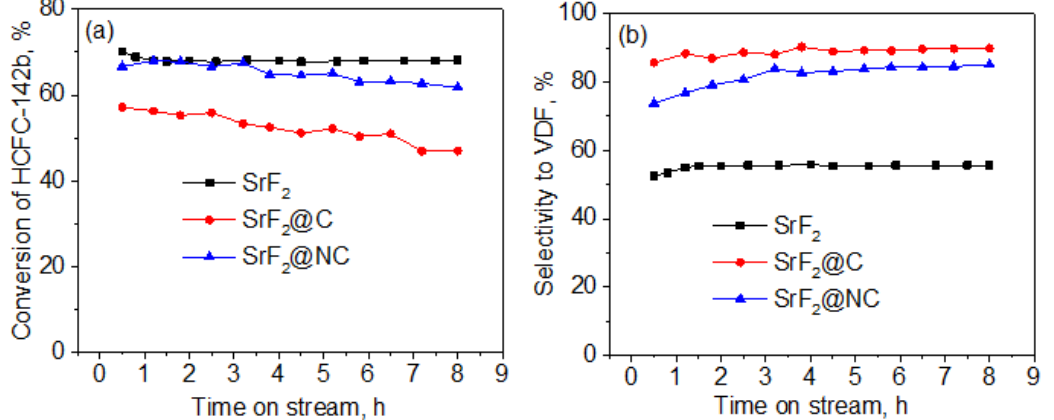
Figure 1. Catalytic performance of SrF 2 catalysts for the decomposition of HCFC-142b. ( a ) Conversion of HCFC-142b and ( b ) selectivity to vinylidene fluoride (VDF). Reactions were carried out at 350 ° C, 1 bar, GHSV (HCFC-142b) of 600 h −1 with N 2 :HCFC-142b of 1:1.